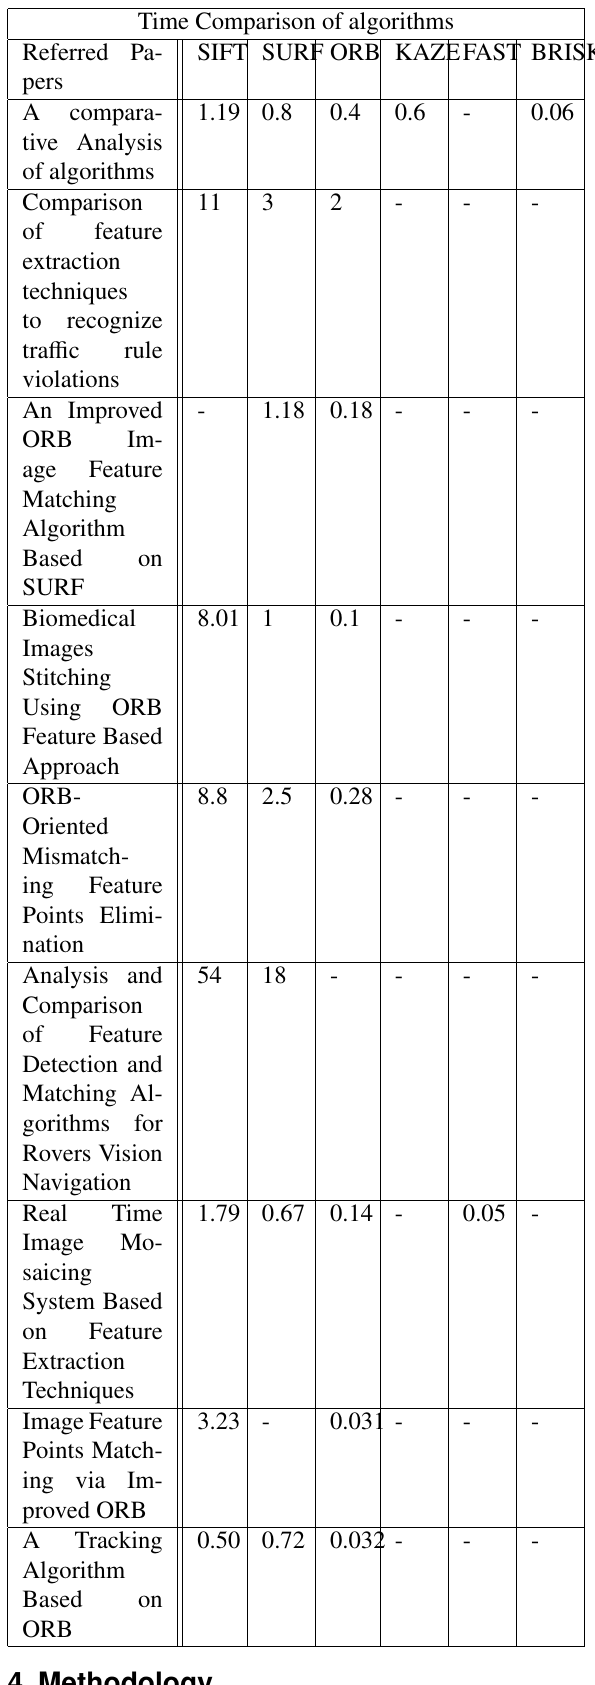
Table 2. Time Comparison of